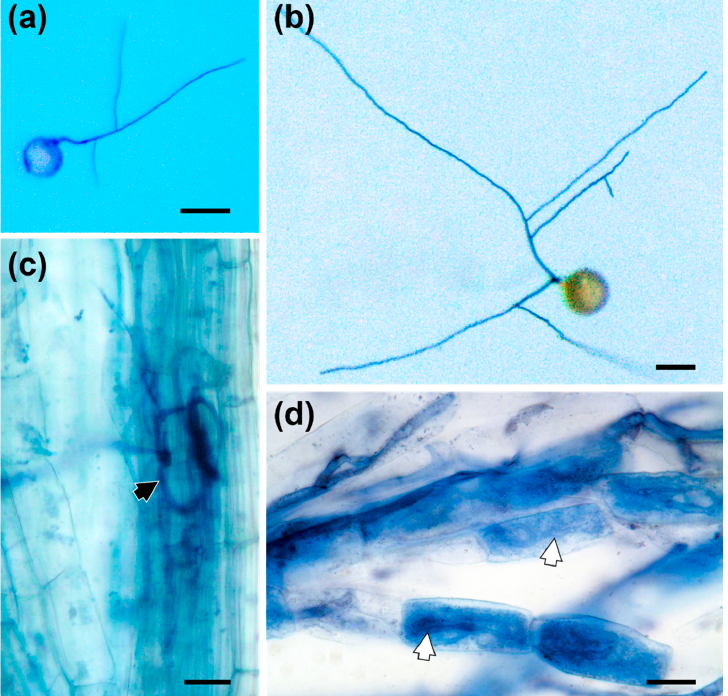
Figure 3. Germination and colonization potential of secondary spores (SS). ( a ) A germinating SS (10 d); ( b ) Germinated mother spore (10 d); ( c ) Intraradical hyphae (indicated by black arrowhead) formed by SS; ( d ) Arbuscular structures (indicated by white arrowheads) formed by the mother spore. Scale bars in ( a , b ) represent 100 µm; scale bars in ( c , d ) represent 50 µm.